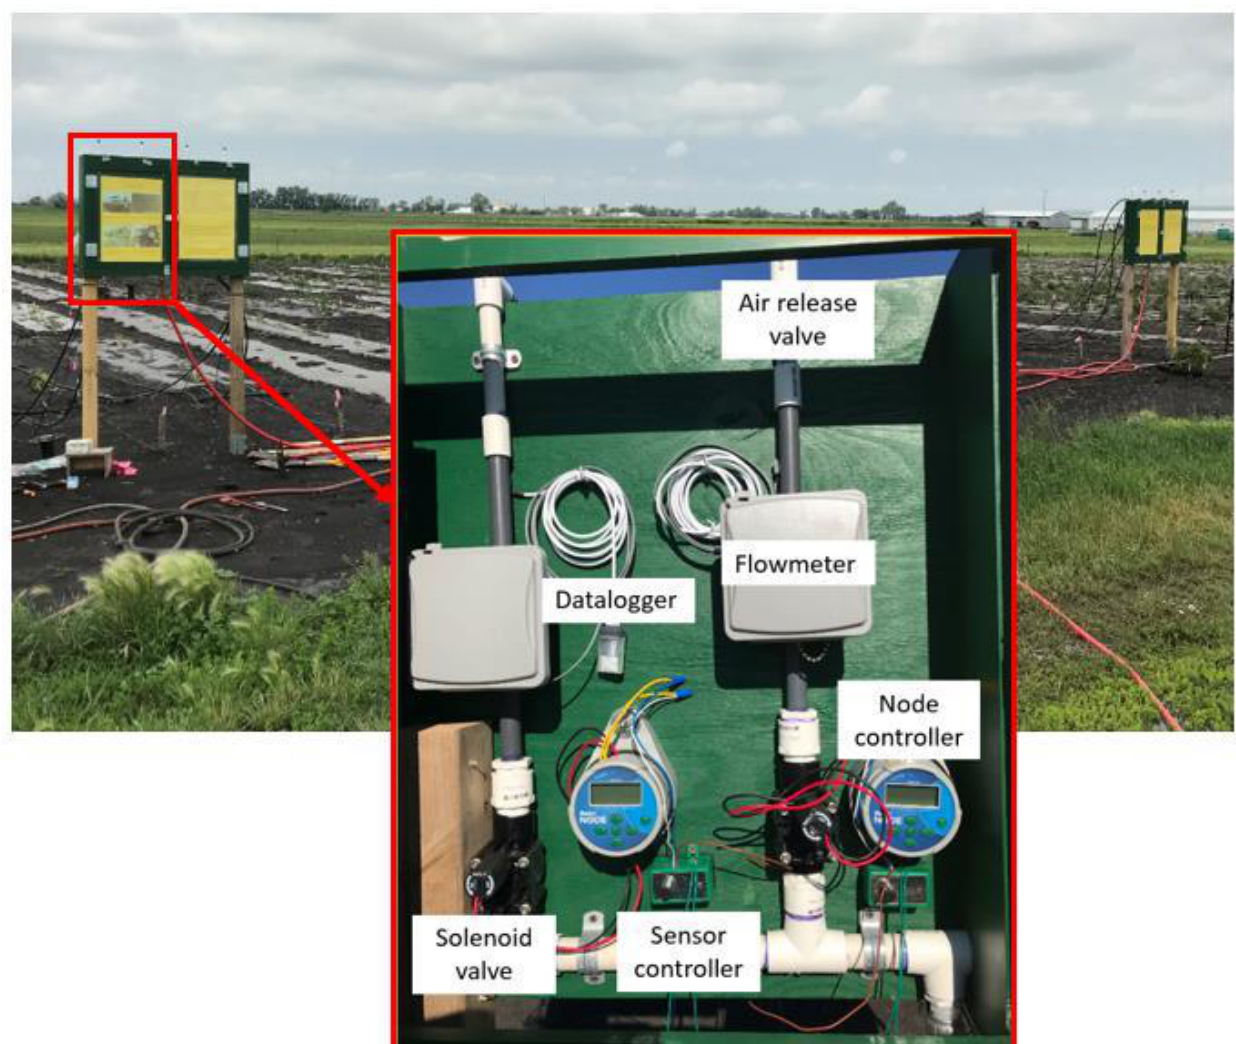
Figure 2. Irrigation controller board with two control units.